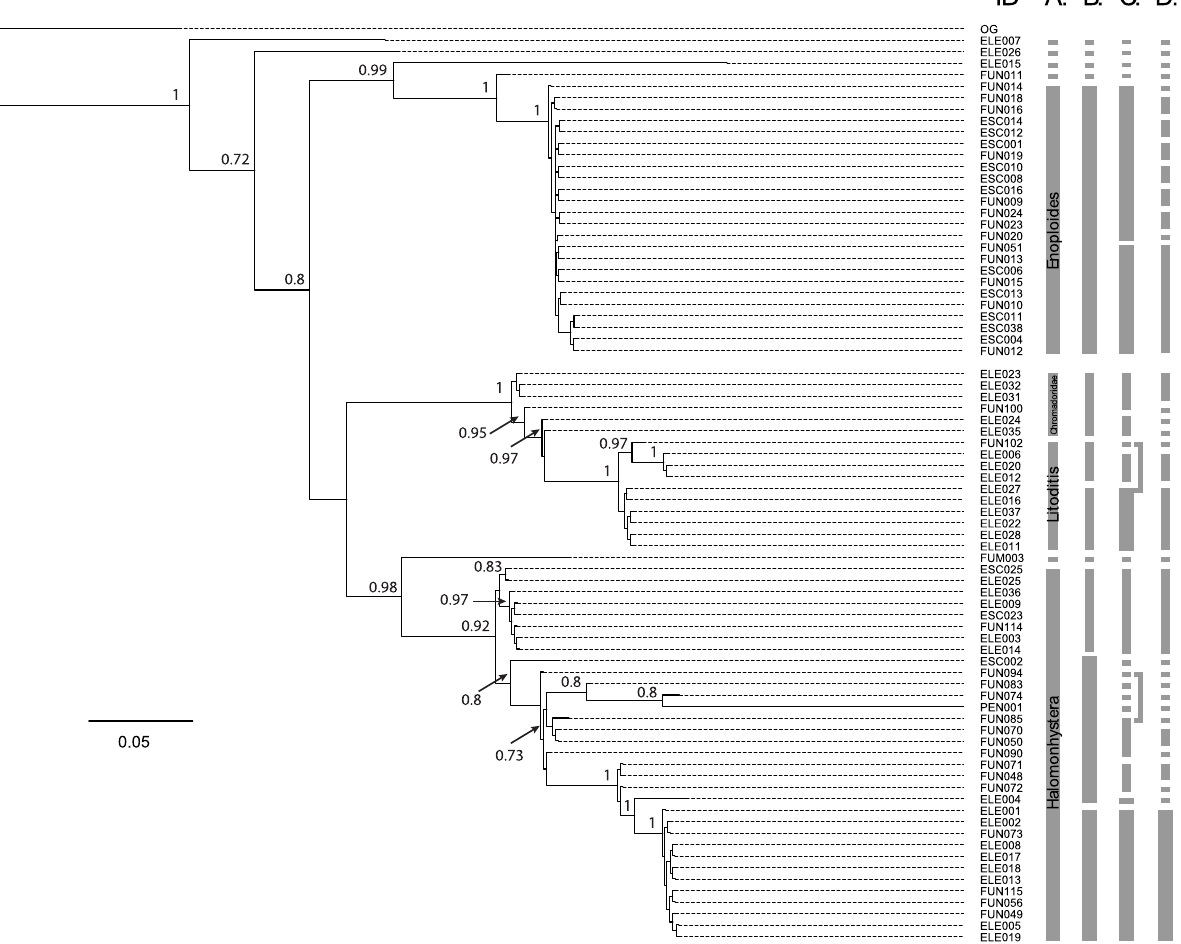
Fig 3. Bayesianconsensus phylogenetic tree of nematodes collected in Antarcticainferred by LSU, SSU1, and SSU2 gene fragments. The grey columns indicatethe species identified by the different approaches.ID indicatesthe specimen identificationnumber. A. indicatesthe species identifiedonly by morphology(see S1 Table); B. indicatesthe putative species identifiedby high support clusters obtainedwith the SSU1 phylogenetic tree for the more abundantmorphologicalspecies (e.g. Halomonystera and Litoditis , S3 Fig); C. indicatesthe putative speciesidentifiedusing the MolecularOperational TaxonomicUnits approach,the cut-off value was a similarity of 99%; D. indicatesthe putative species identifiedusing the Bayesian implementation of the Poissontree processes (bPTP) model for species delimitationbasedon the molecularphylogenetic